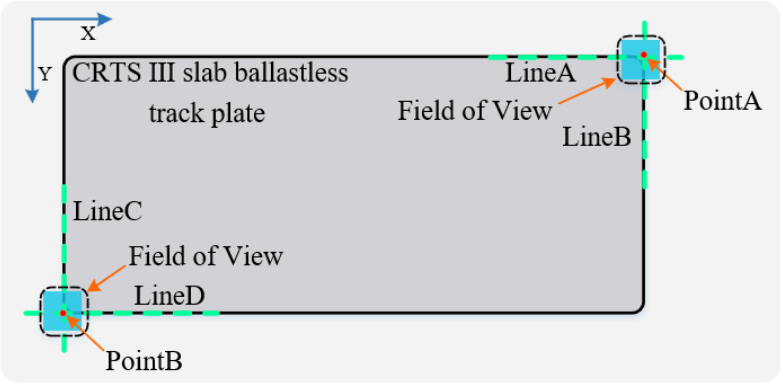
Figure 3. Schematic diagram of the positioning principle of the visual localization system.